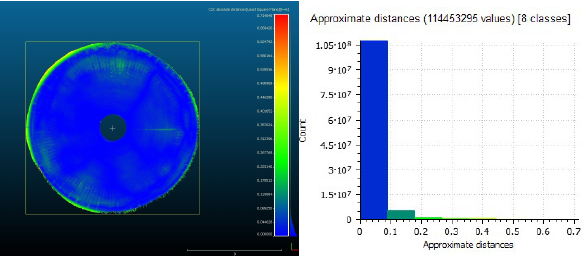
Figure 8: Discrepancy (m) map and histogram between the TLS point cloud and EOS3 – UltraHigh processing.